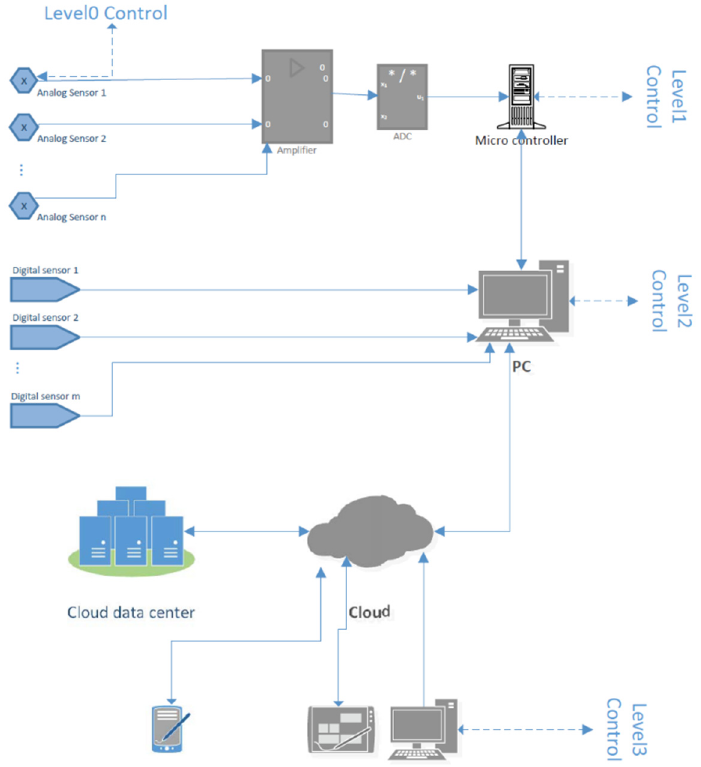
Figure 13. Proposed architecture system based on multi-sensor technology.